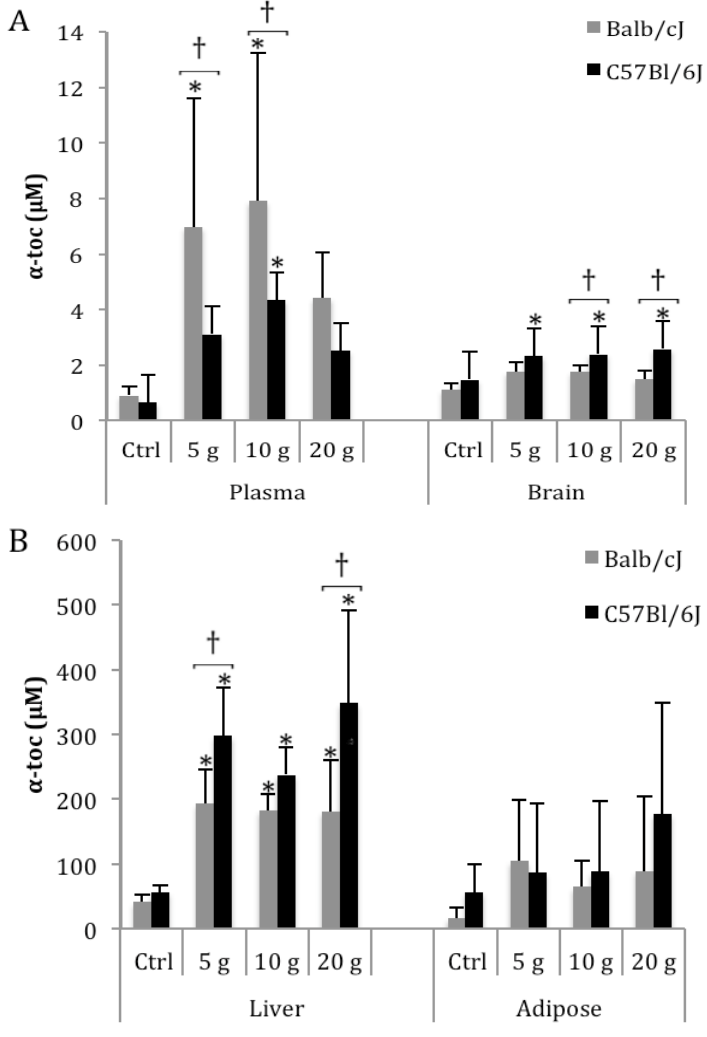
Figure 1. Mean plasma, brain, liver, and adipose α -toc levels following 4 weeks high dosage α -toc dietary administration to adult Balb/cJ and C57Bl/6J mice. Supplementation at 5, 10, or 20 g α -toc/kg diet resulted in significantly different α -toc levels in plasma ( A